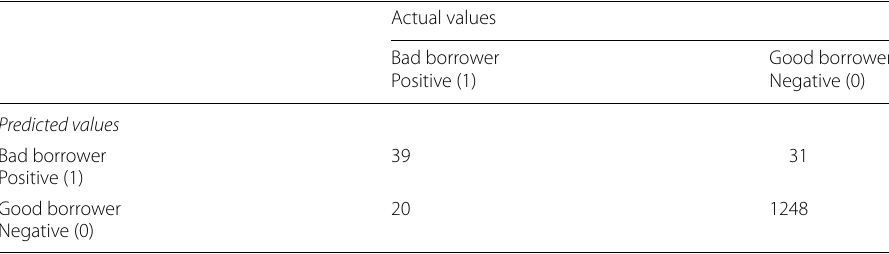
Table 6 Confusion matrix—on-site supervision approach